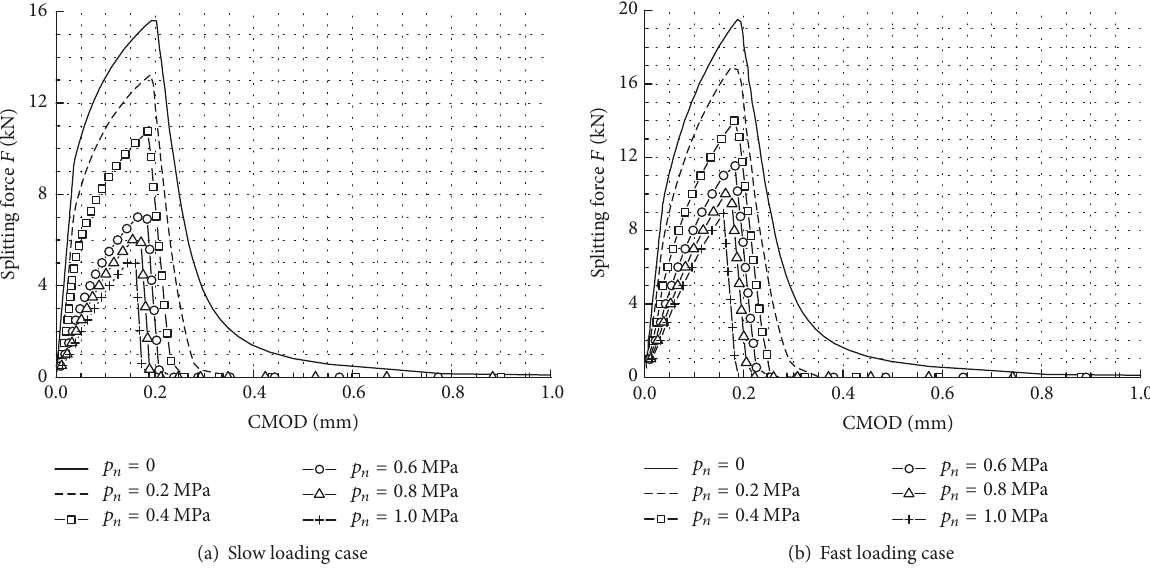
Figure 12: Effect of water pressure at the crack mouth on the fracture property.